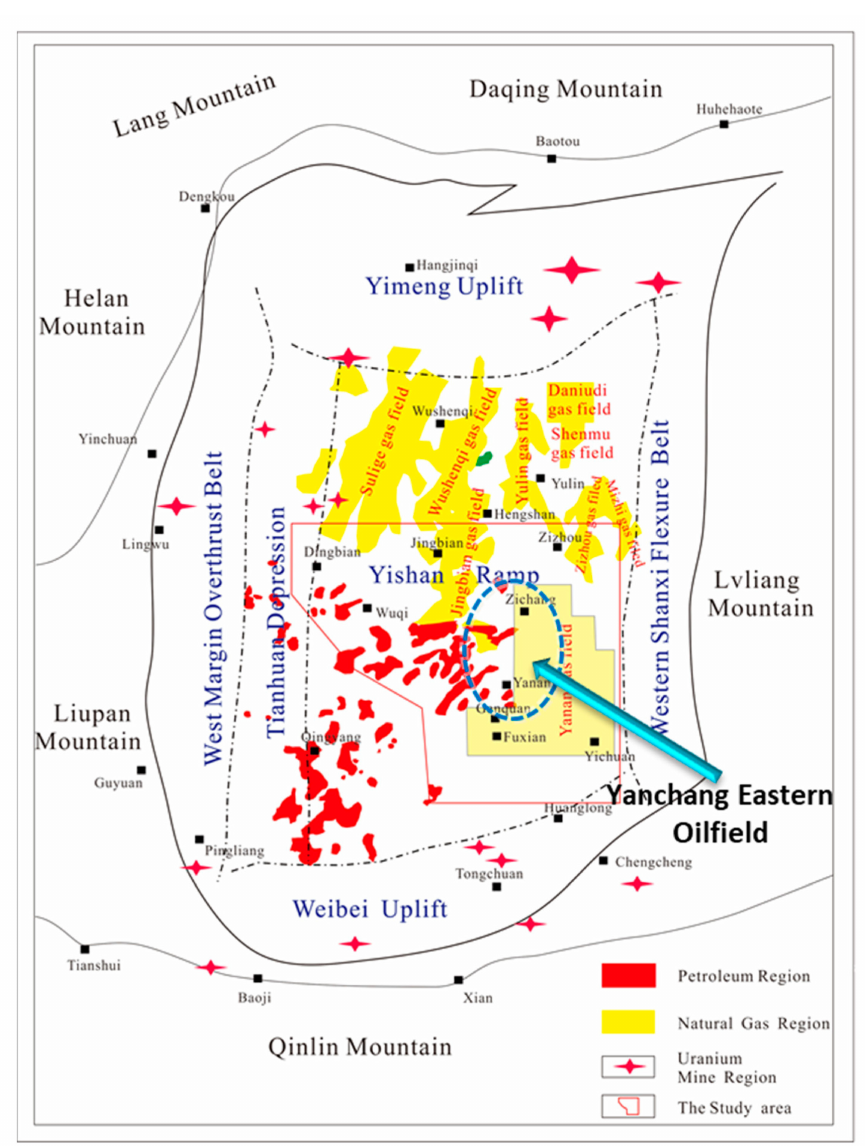
Figure 1. Location map of the Yanchang Eastern Oilfield in the Ordos